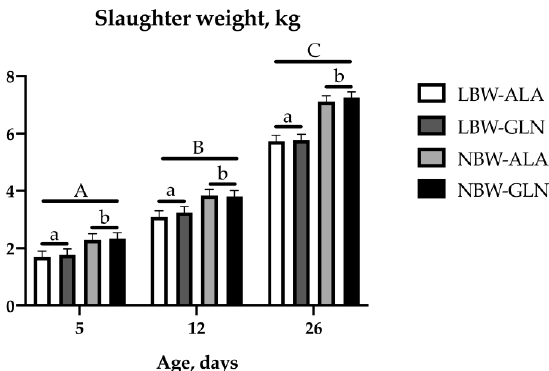
Figure 1. Slaughter weights of low birth weight (LBW) piglets and their normal birth weight (NBW) littermates supplemented with glutamine (GLN) or an isonitrogeneous amount of alanine (ALA) between 1 and 12 days post natum (dpn). Twelve piglets per group were each slaughtered at 5, 12, or 26 dpn; a,b indicate significant differences between LBW and NBW piglets at the same age; A–C indicate significant differences among ages ( p ≤ 0.05, Tukey–Kramer test).